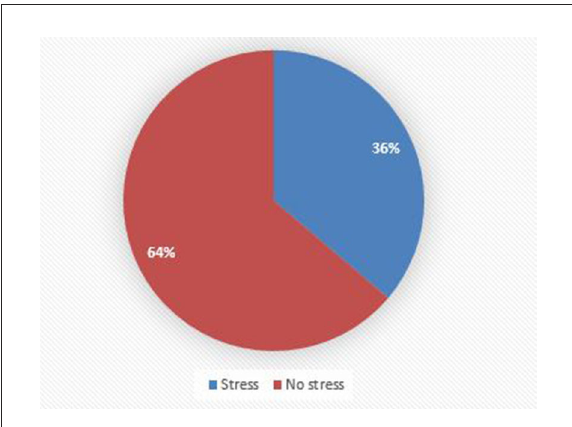
FIGURE3 Psychological status of female college students, Debre Berhan, Ethiopia, 2021 ( n =